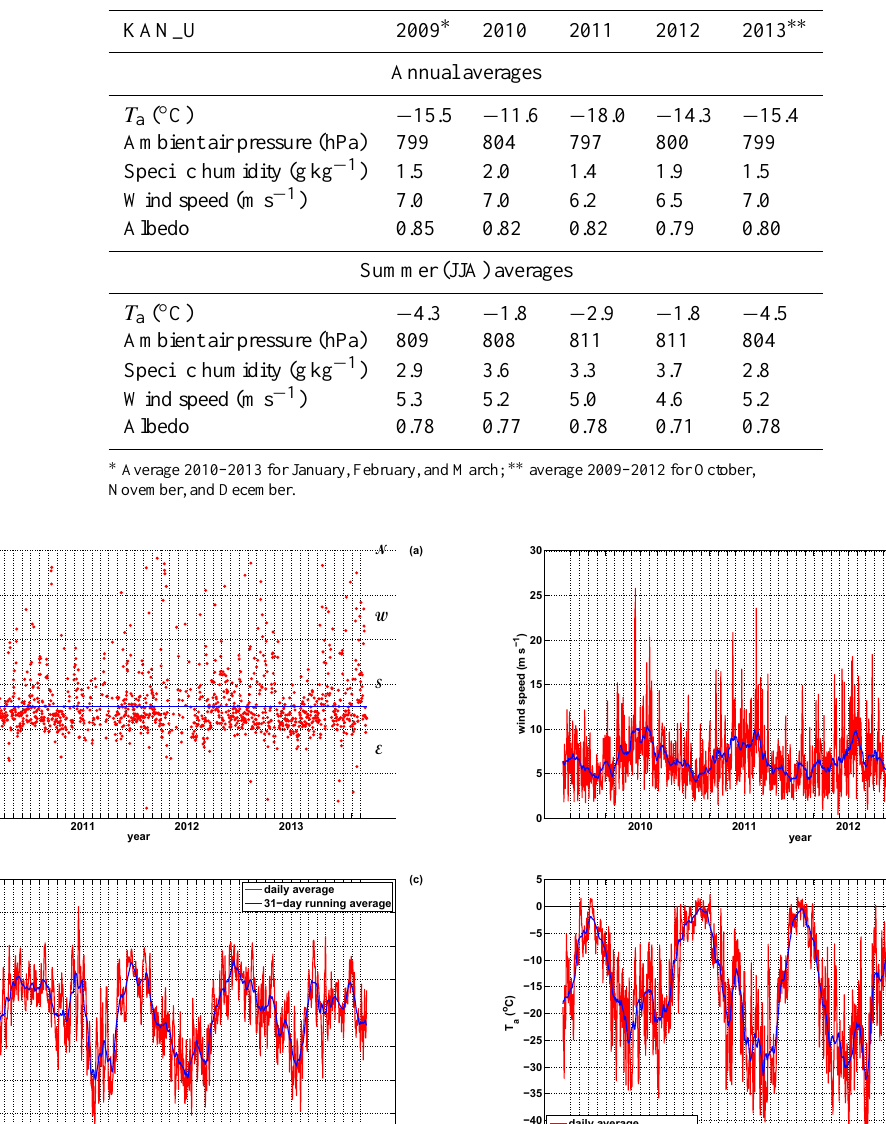
Table 3. Annual and summer (June–July–August) average meteorological parameters at KAN_U.